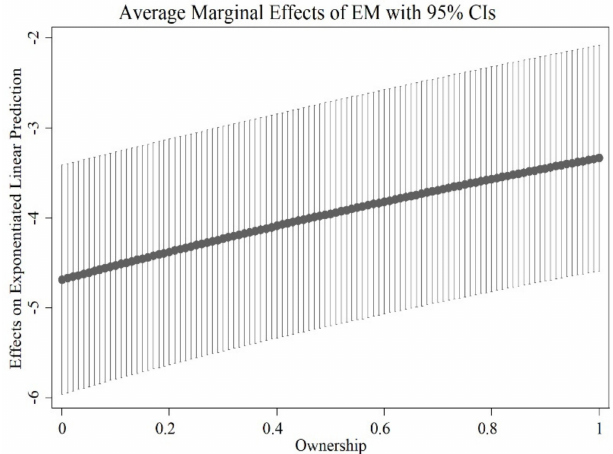
Figure 3. The marginal e ff ect of environmental munificence on technological diversification over